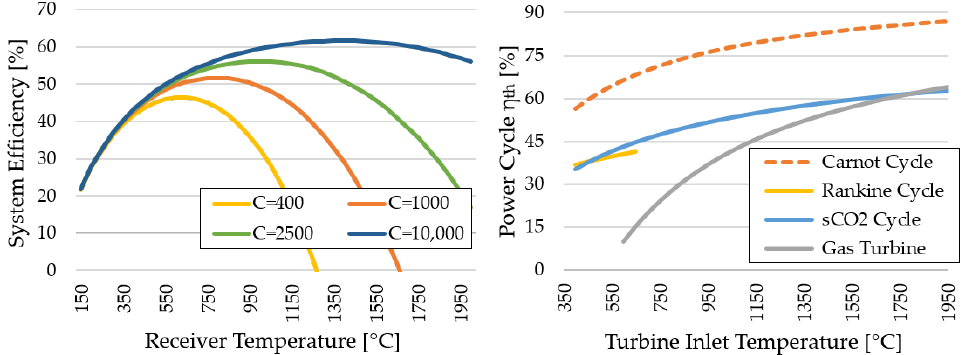
Figure 5. System efficiency of a concentrated solar power plant as a function of solar receiver temperature and concentration ratio ( left ) and power block thermal efficiency as a function of turbine inlet temperature for various power cycle technologies ( right